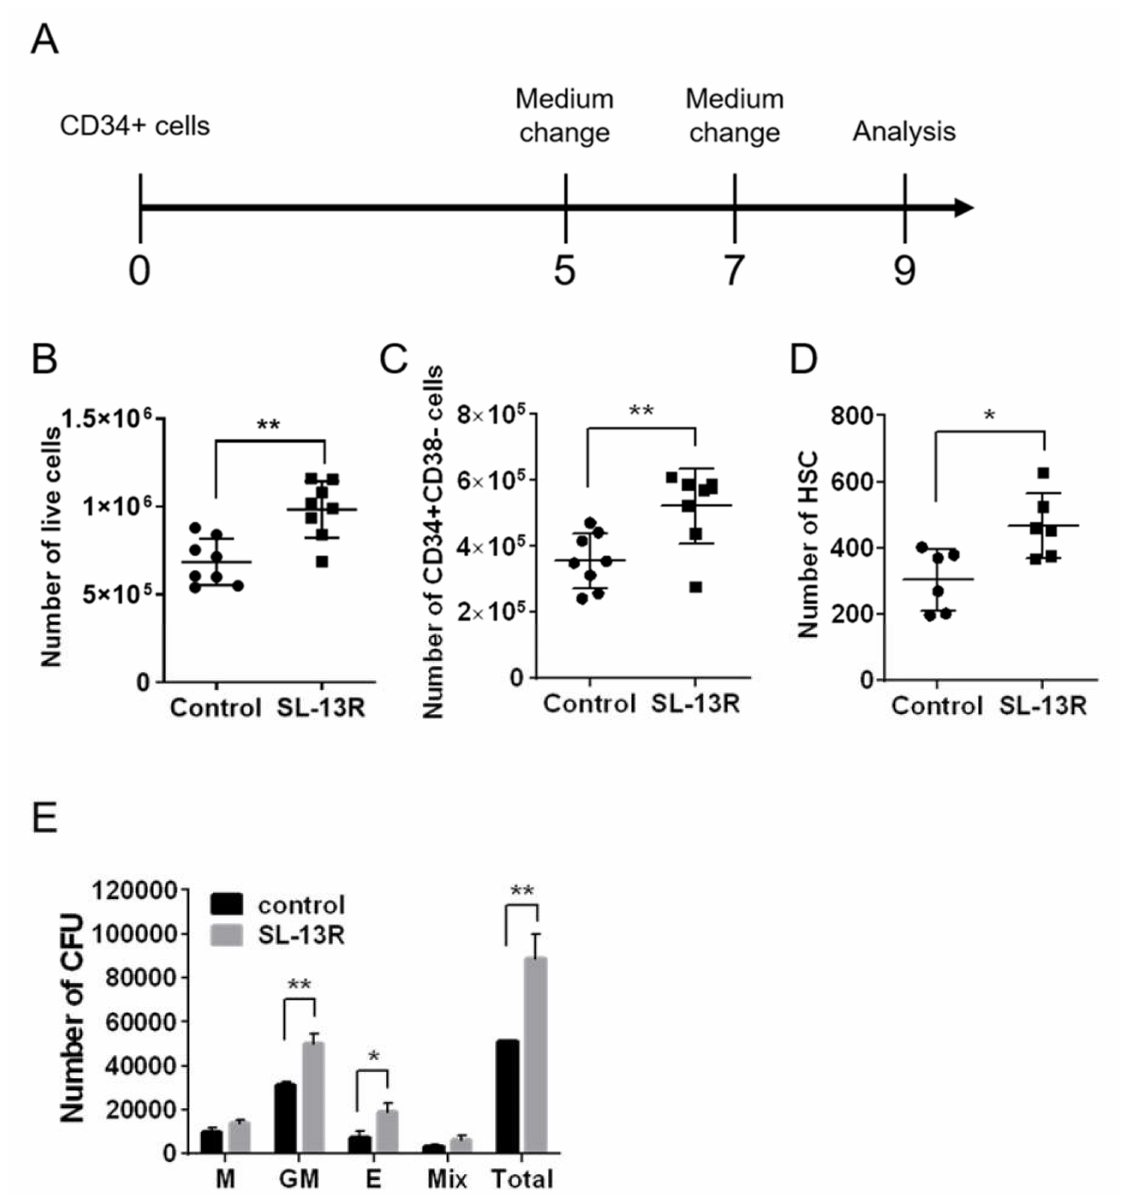
Figure 1. Ex vivo expansion of human UCB HSPCs by SL-13R peptide. ( A ) Human UCB CD34+ cells were cultured with or without SL-13R peptide (10 µ g/mL) for 9 days and analyzed ( B ) The number of live cells with or without SL-13R (control: n = 8, SL-13R: n = 8). ( C ) The number of CD34+ CD38- cells with or without SL-13R (control: n = 8, SL-13R: n = 8). ( D ) The number of HSCs (CD34+, CD38 − , CD45RA − , CD90+, CD49f+ cells) with or without SL-13R (control: n = 6, SL-13R: n = 6). ( E ) The number of colony forming unit (CFU) with or without SL-13R (control: n = 3, SL-13R: n = 3). The con-trol was PBS treatment. Student t test was used to test intergroup differences. * p < 0.05, ** p <